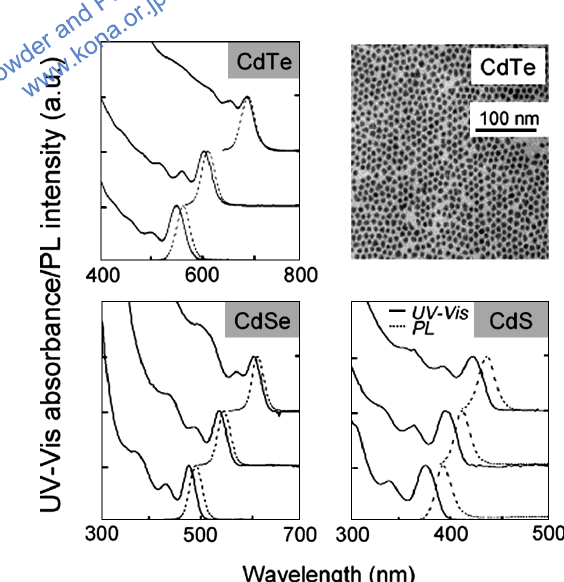
Fig. 1 UV/Vis and PL spectra of CdTe, CdSe and CdS nano- crystal samples. A typical TEM image of CdTe is shown in the upper right corner. Reprinted with per- mission from Yu et al., “Experimental Determination of the Extinction Coefficient of CdTe, CdSe, and CdS Nanocrystals” Chem. Mater. 2003 15(14), p. 2854– 2860. Copyright 2003 American Chemical